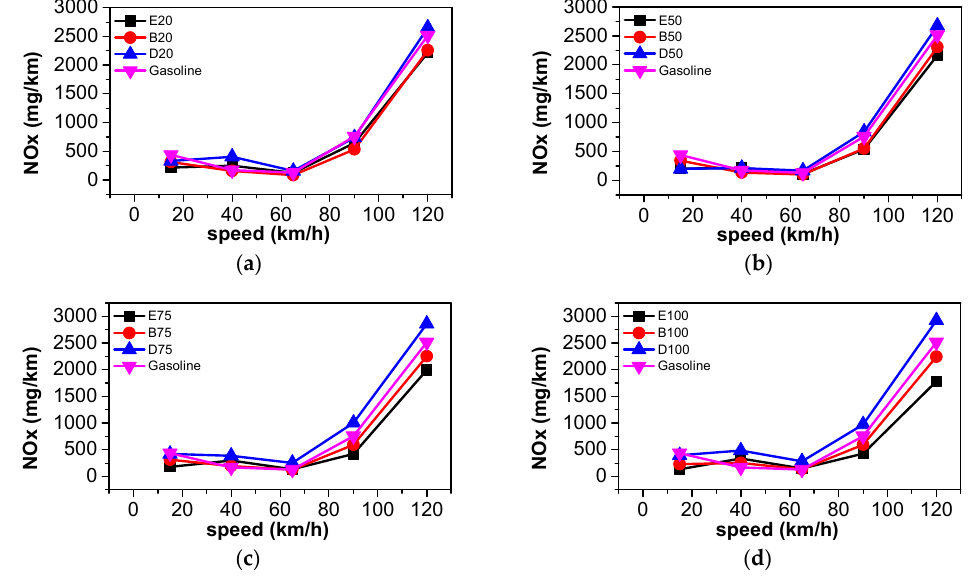
Figure 9. Comparison of NO X emissions of different fuels at different blending ratios: (a) 20% blending ratio; (b) 50% blending ratio; (c) 75% blending ratio; and (d) 100% blending ratio.